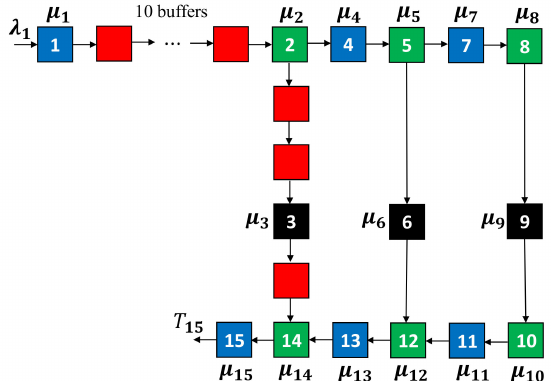
Figure 13. Production line topology after bu ff ers are allocated by API-VNS in the case of λ = 0.4 in experiment